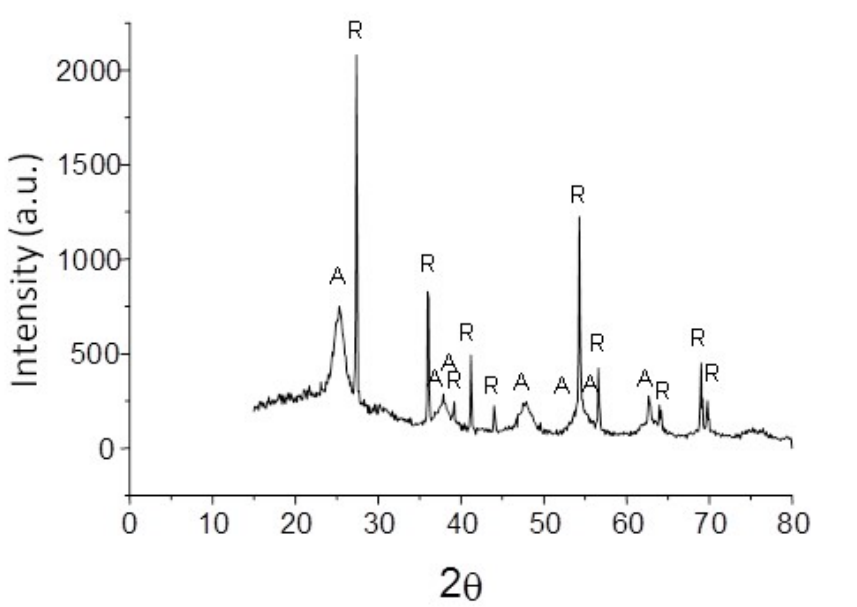
Figure 6. X-ray diffraction pattern obtained from the TiO 2 scaffolds, A—anatase, R—rutile.